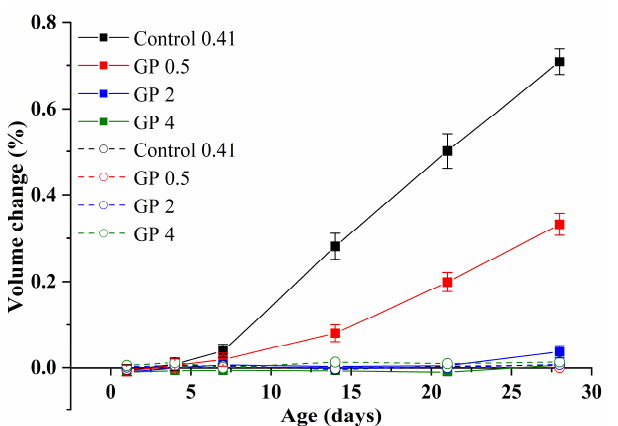
Figure 11. Volume changes of GA mortars under alkali curing at 80 °C (solid line) and water curing at 80 °C (dashed line).